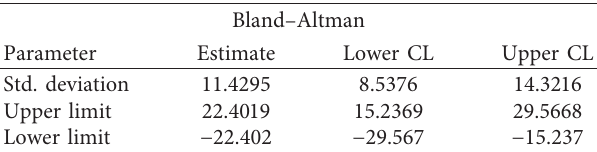
Table 3: Descriptive statistics from the Bland–Altman